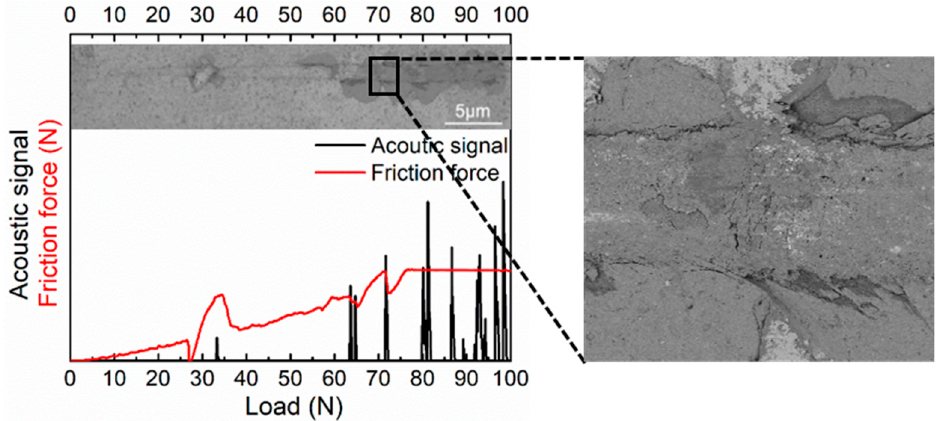
Figure 4. Scratch morphologies and back scattered-electron image of the TiN/ZrN nanoscale multilayer coating.